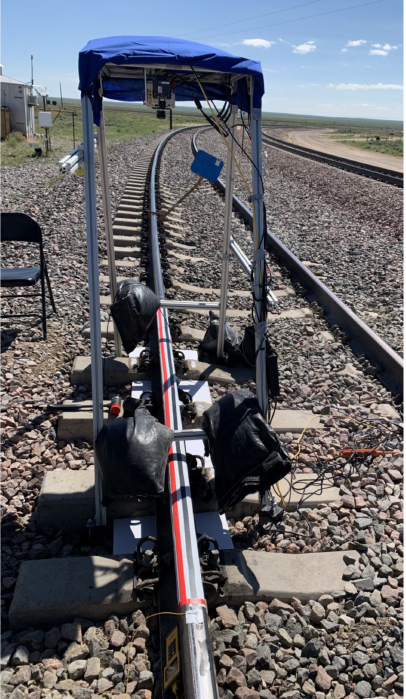
Figure 1. Photo of the railroad section tested in